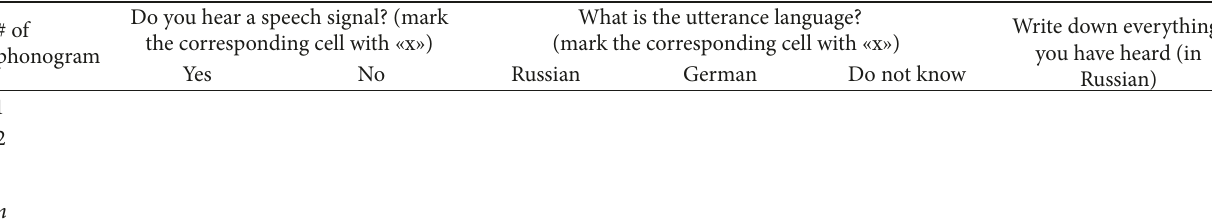
Table 2: Answer table for listeners.